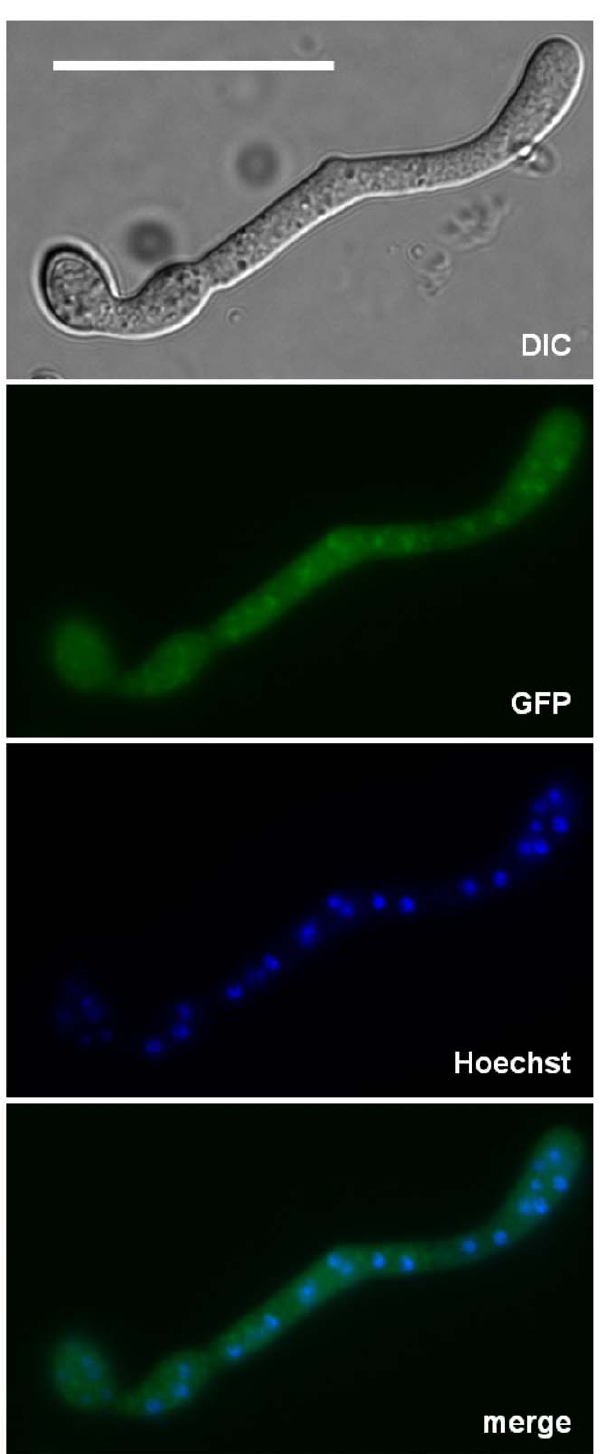
Figure 5. Localization of GFP-BcRcn1 in B. cinerea . The strain D bcrcn1 was transformed with a gfp - bcrcn1 fusion construct under the control of the constitutive oliC -promoter. Fluorescent protein was demonstrated to be homogenously distributed at a basal level in the cytoplasm but accumulated around or in the nuclei. Nuclei were visualized by using the fluorescent dye Hoechst 33342 (for details see Materials and Methods). Scale bar: 20 m m.